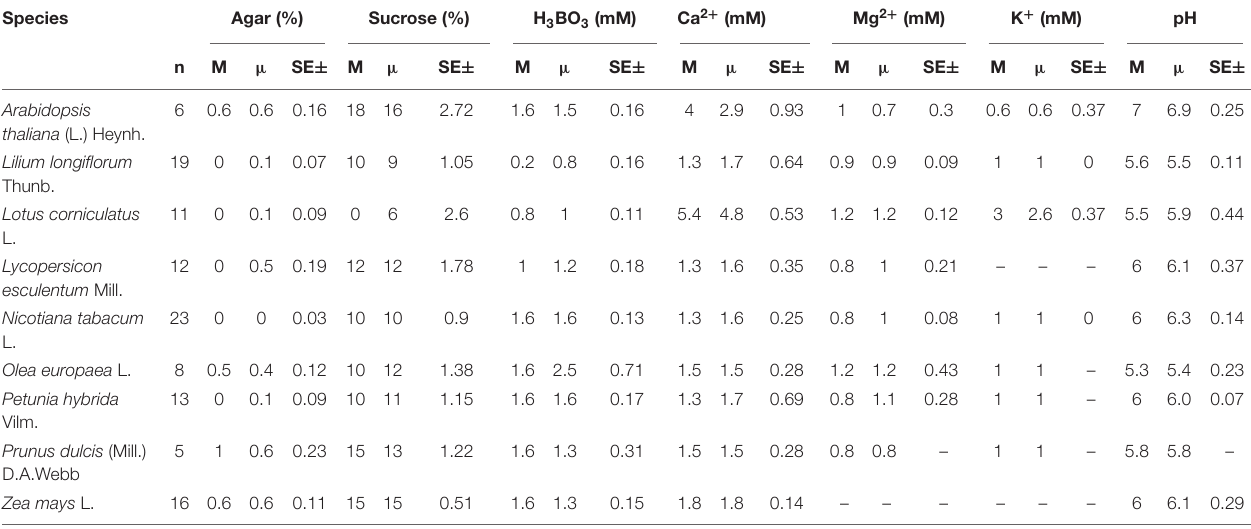
TABLE 2 | The median (M), mean ( µ ) concentrations, and standard error of the most frequently used ingredients in in vitro pollen germination media for the most studied species. Species Agar (%)